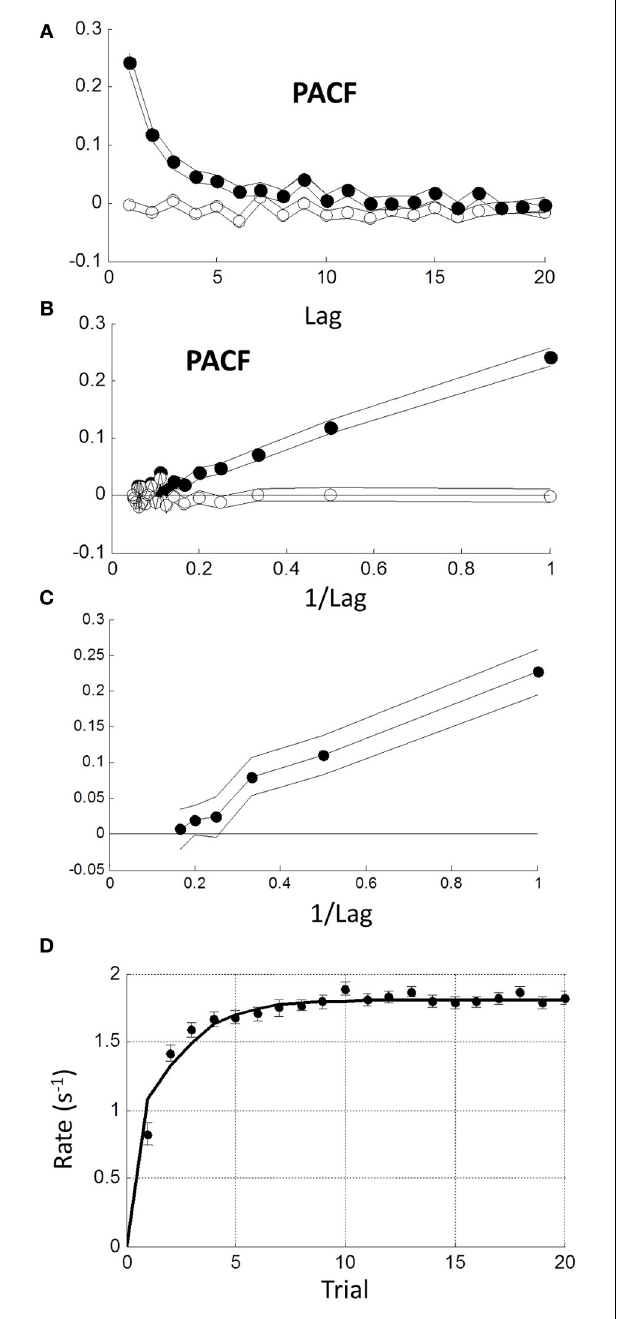
FIGURE 8 | Sequential dependency based on blocks without transients (first 10 trials omitted). (A) Mean partial autocorrelation function (PACF) of all blocks (filled symbols) showing smooth decay. Lines are ± 1 standard error. Open symbols show PACF for the same data after random shuffling leaving no sequential dependency. (B) PACF is plotted against reciprocal of lag showing a roughly linear increase (filled symbols). After de-correlation (see text) PACF coefficients become negligible (open symbols). (C) Maximum likelihood estimation of autoregressive coefficients (Equation 1.1) using the Box-Jenkins methods (see Methods) showing linear increase with reciprocal lag. (D) Comparison of step response function of autorgressive model (solid curve) with observed initial transient from grand mean in Figure 7B